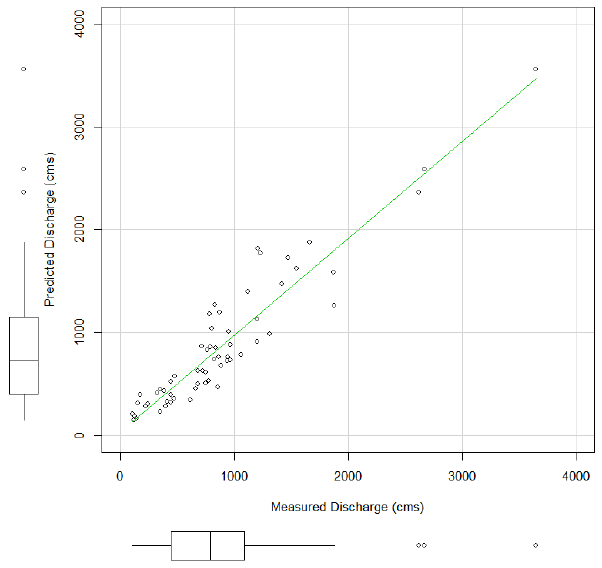
Figure 2. Regression model